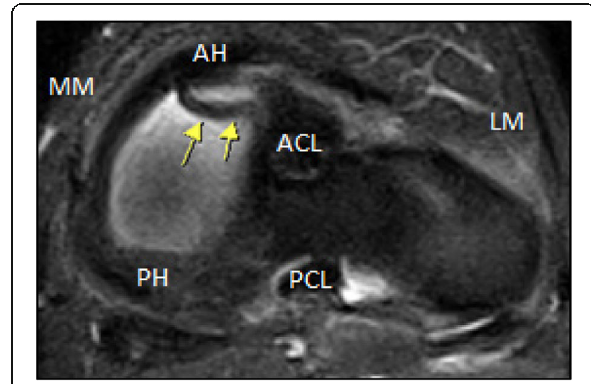
Fig. 9 Axial fat PD WI revealed a displaced flap tear. Note the rather attenuated body secondary to displaced meniscal flap tear from the free meniscal edge, in the anterior aspect of the medial femorotibial joint compartment. LM = lateral meniscus, MM = medial meniscus, AH = anterior horn, PH = posterior horn, PCL = posterior cruciate ligament, and ACL = anterior cruciate